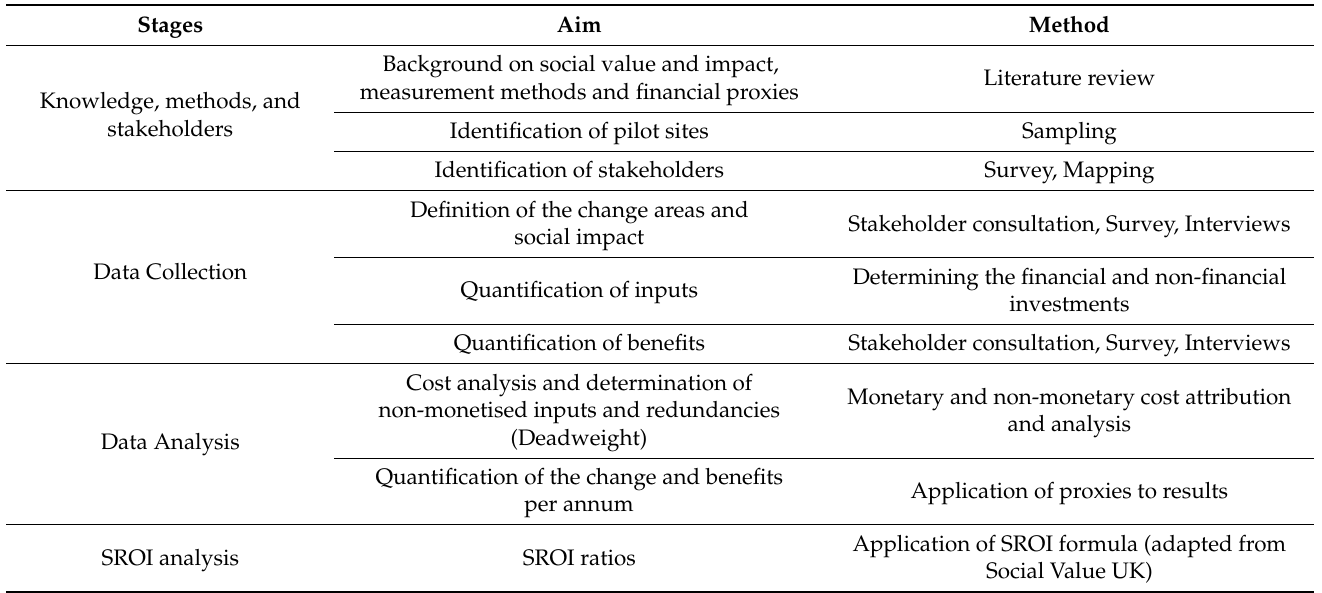
Table 1. Research design (after: